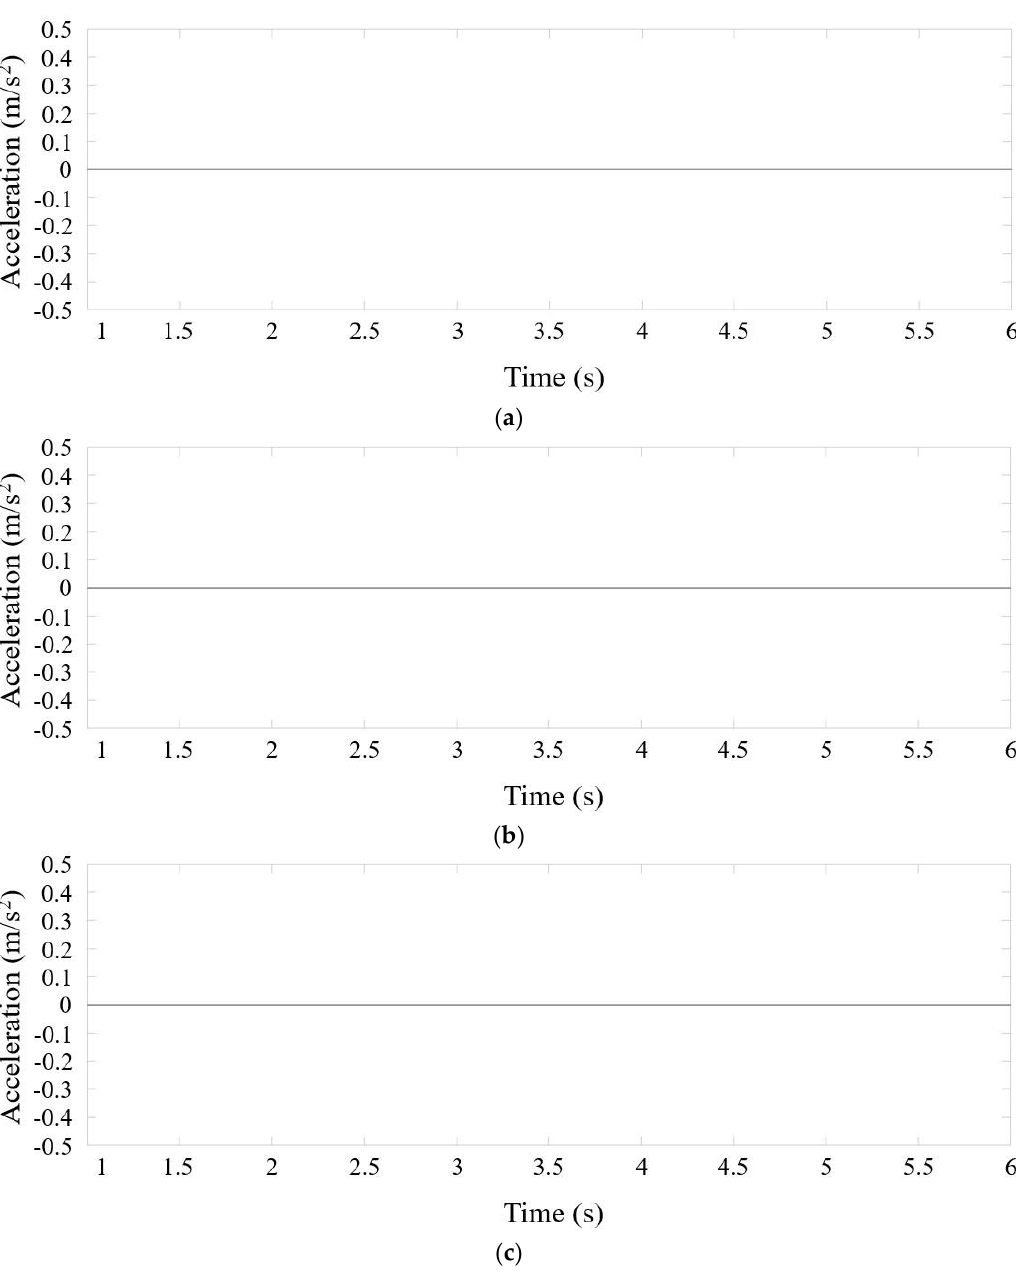
Figure 8. The vertical accelerations of the swing shaft ( a ), the lower die ( b ) and the frame ( c ).